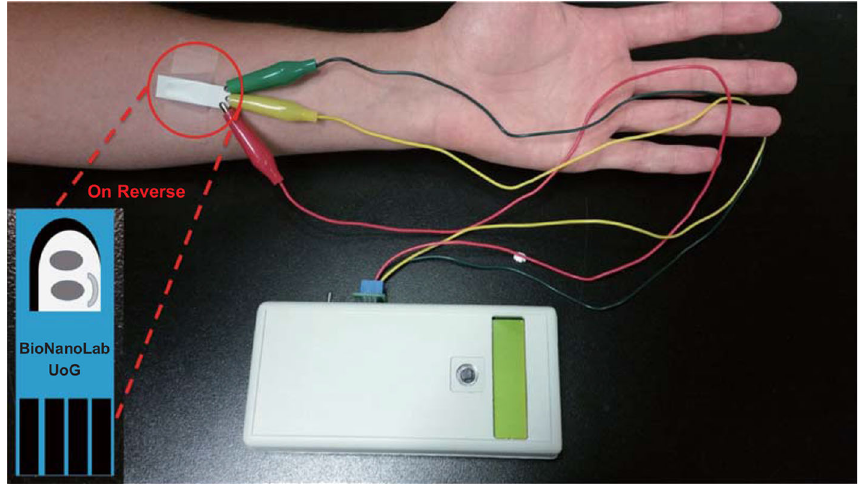
Fig. 1 Schematic representation of a portable, handheld potentiostat assembled with Bluetooth communication and battery operation to allow for point-of-care applications. The prototype electrode is attached to patient’s arm and connected to handheld potentiostat to run test, and data will be sent to the mobile app to be displayed to the